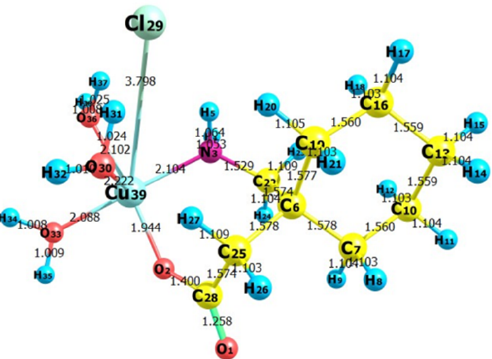
Figure 18. The optimized structure of the synthesized metal complex [Cu(II)–(Gpn)] showing bond lengths. Table 6. The bond lengths of the metal complex [Cu(II)–(Gpn)] obtained through DFT. S. No.